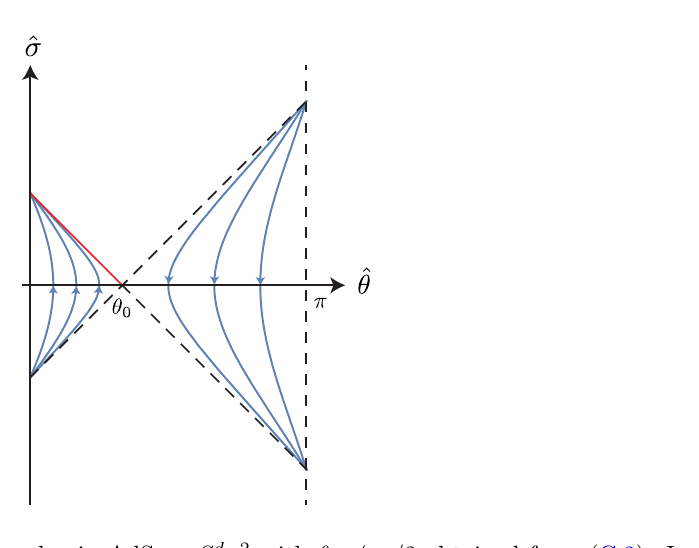
Figure 9 . Modular (cid:13)ow for a wedge in AdS 2 (cid:2) S d (cid:0) 2 with (cid:18) 0 6 = (cid:25)= 2 obtained from (C.2). In the left wedge (cid:18) < (cid:18) 0 we indicate its future horizon in red, described by (C.3). Open